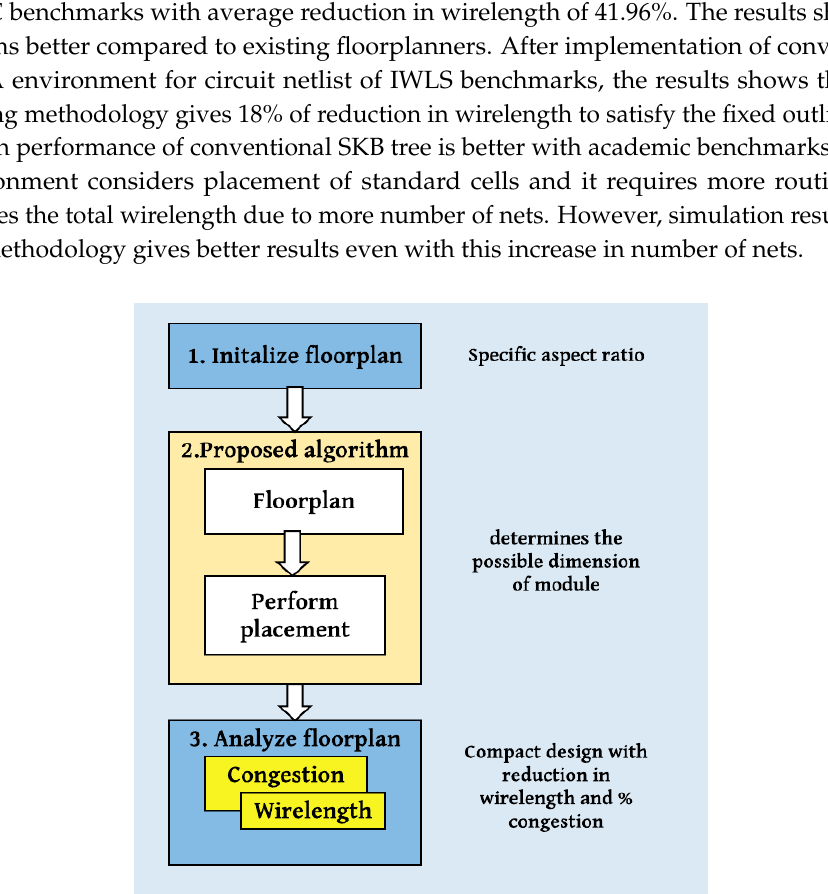
Figure 8. Cadence design flow incorporated to analyze congestion and